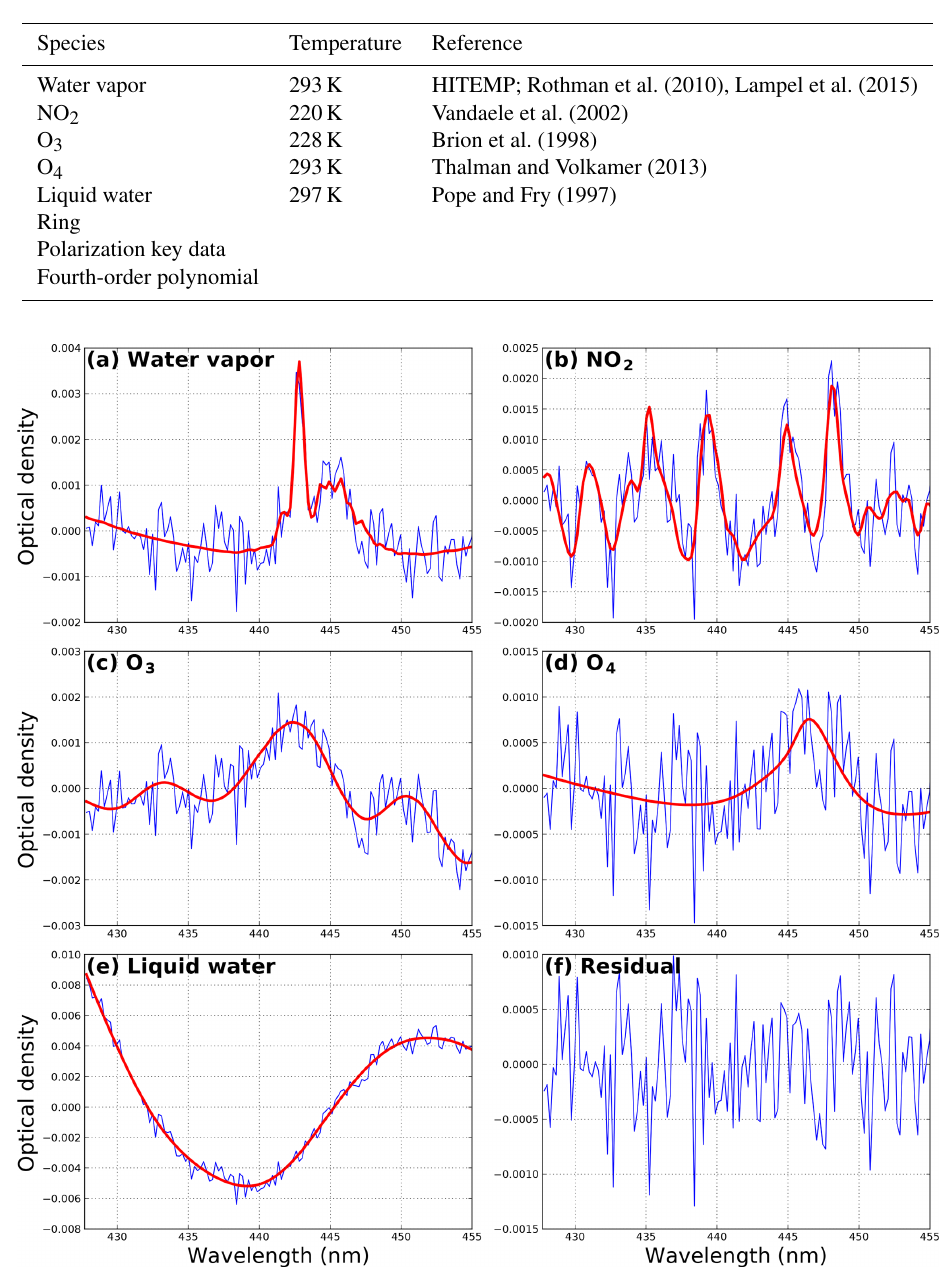
Figure 3. An example of the DOAS retrieval of water vapor slant columns from a GOME-2A spectrum over the Pacific Ocean. The retrieved water vapor slant column is 30.6kgm − 2 . The blue curves show measured optical density, with the broadband attenuation removed by subtracting a fourth-order polynomial, and the red curves show the optical density of the scaled reference absorption cross sections.